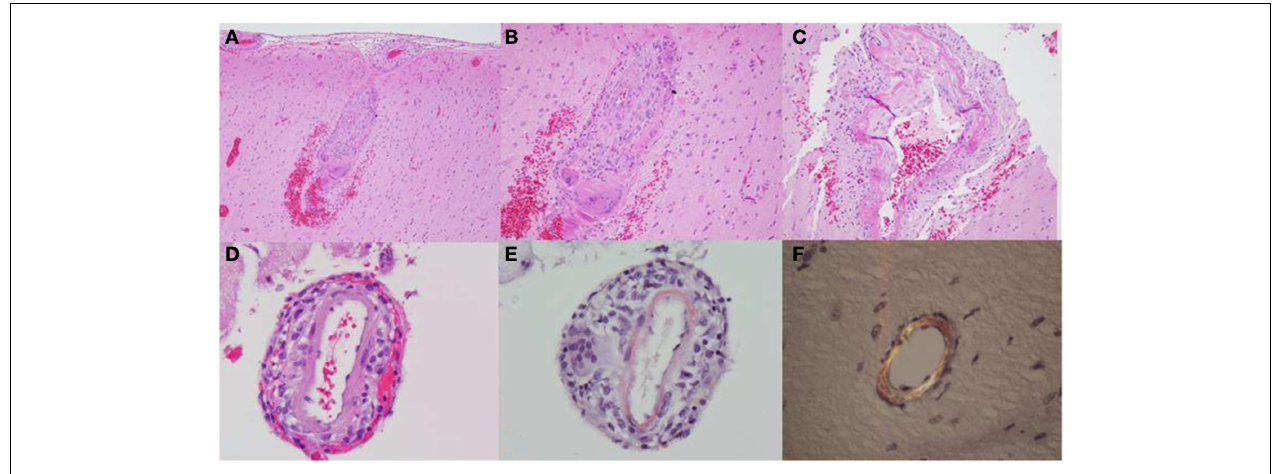
with granulomatous inflammation and amyloid deposition, 400 × . (E) Congo red stain positive for amyloid, 400 × . (F) Congo stain showing characteristic apple-green birefringence under polarized light, 400 ×